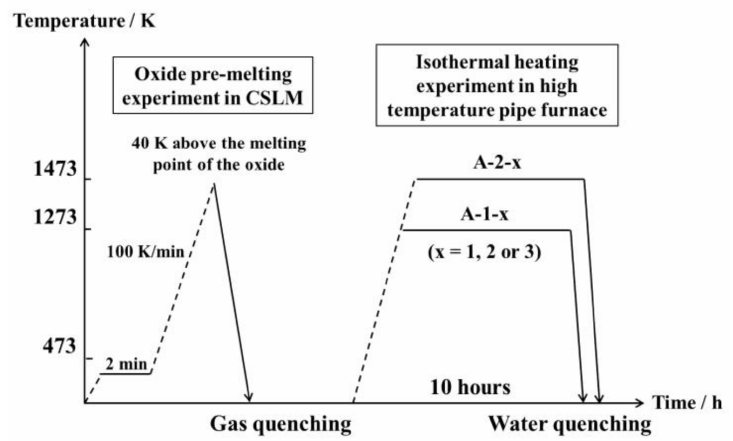
Figure 3. Temperature curves for the isothermal heating of the diffusion